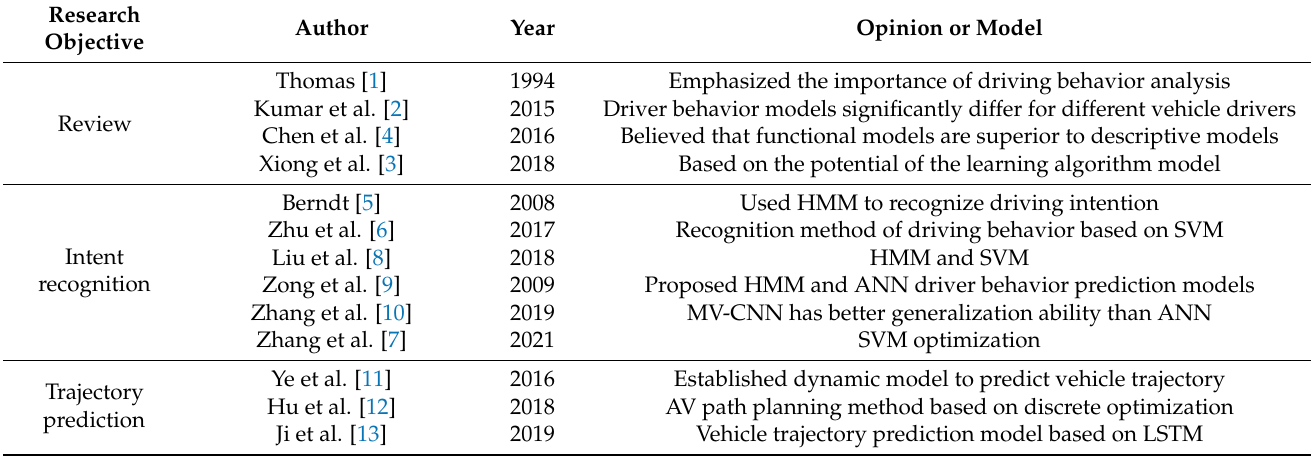
Table 1. Research summary of motion planning models for individual intelligent vehicles.